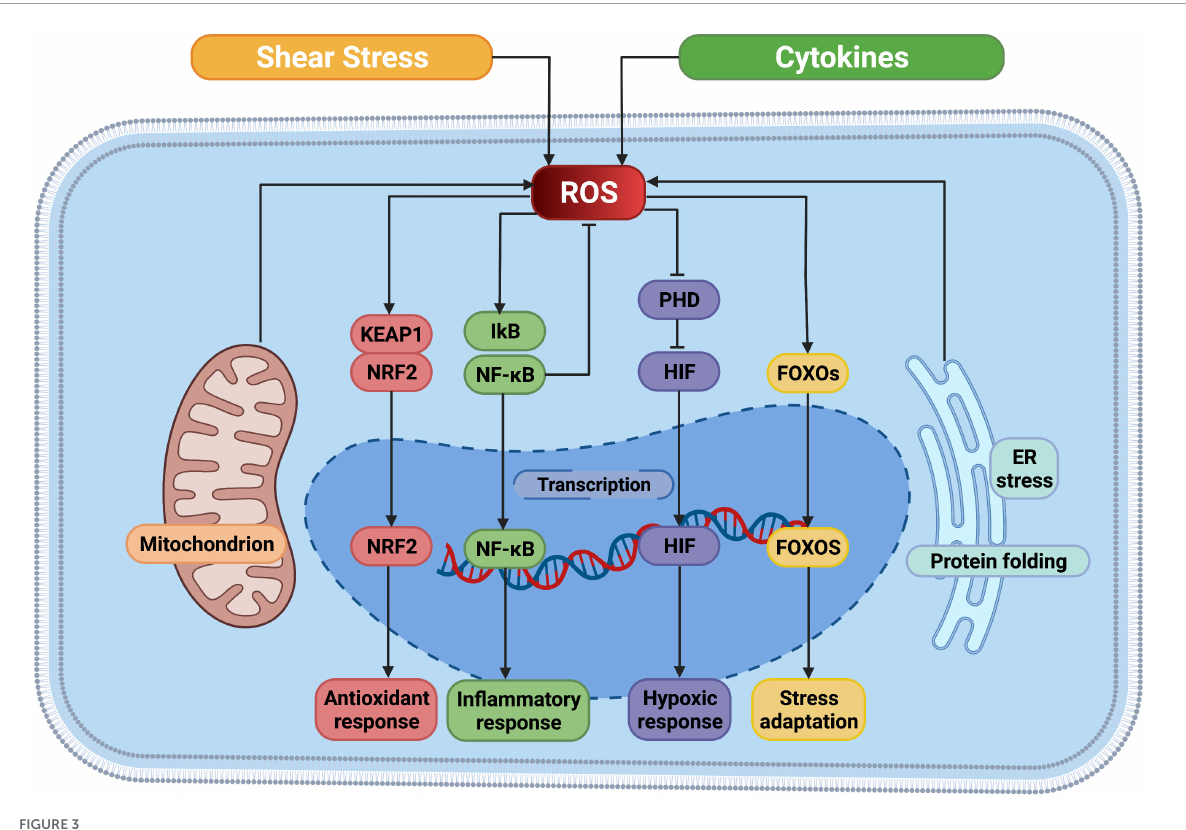
FIGURE3 ROS mediated cellular signaling pathways. ROS, reactive oxygen species; NRF2, nuclear factor erythroid 2-related factor; KEAP1, Kelch-like ECH-associated protein 1; IkB, I-kappa B proteins; NF- κ B, nuclear factor kappa B; PHD, prolyl hydroxylases; HIF, hypoxia-inducible factor; FOXO, forkhead box protein O; ER, endoplasmic reticulum. This figure was generated in Biorender